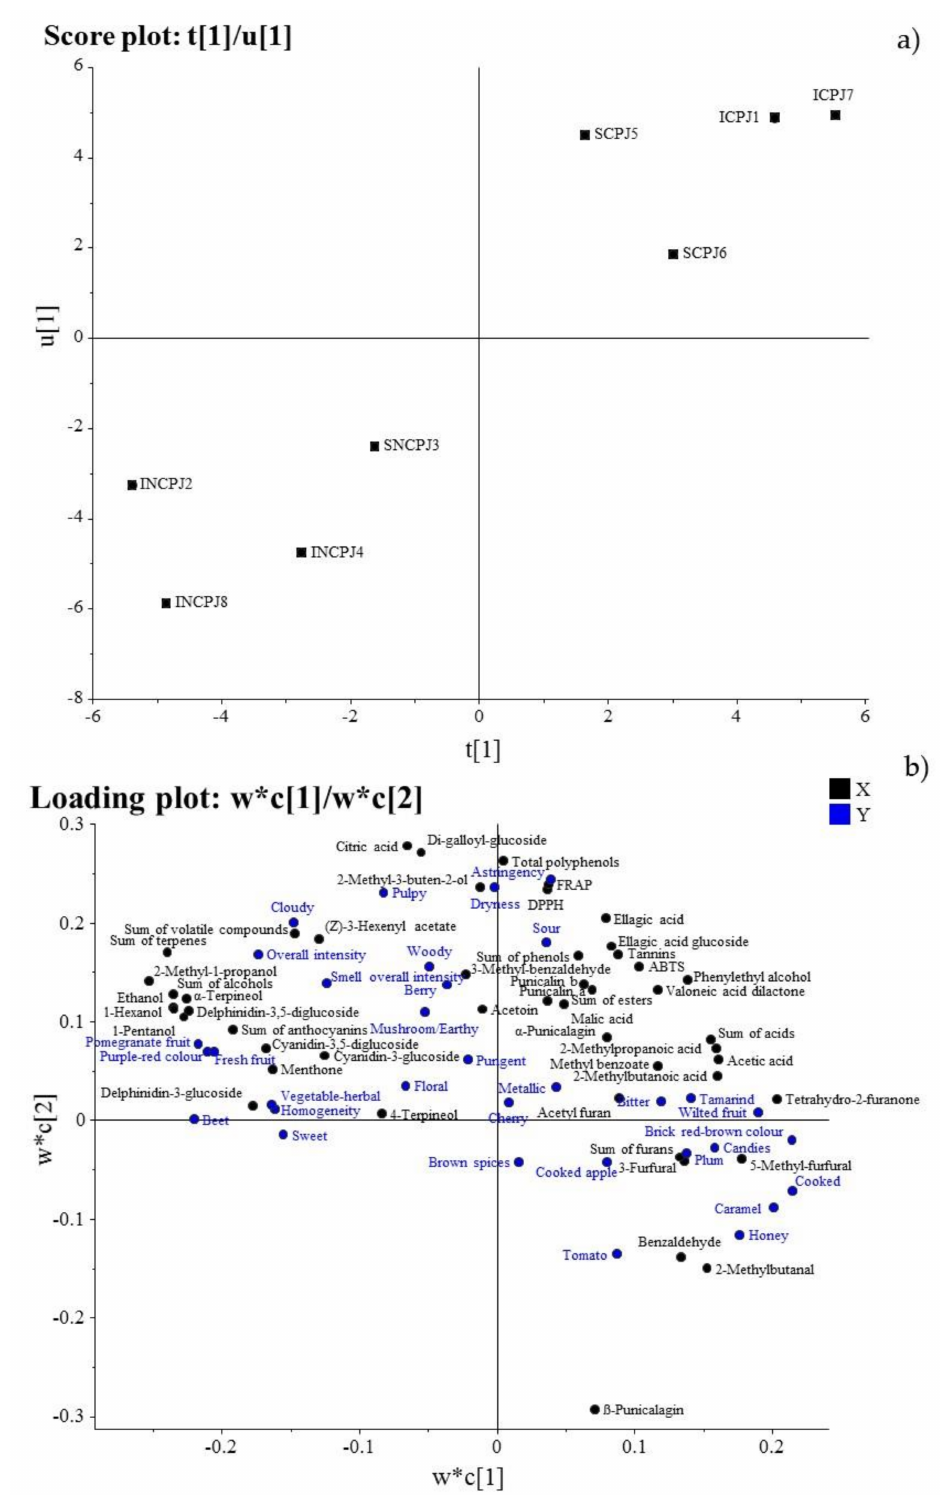
Figure 4. ( a ) Scores plot (t1/u1) of the first latent variable and ( b ) loading plot w*c[1]/w*c[2] of the partial least squares (PLS)